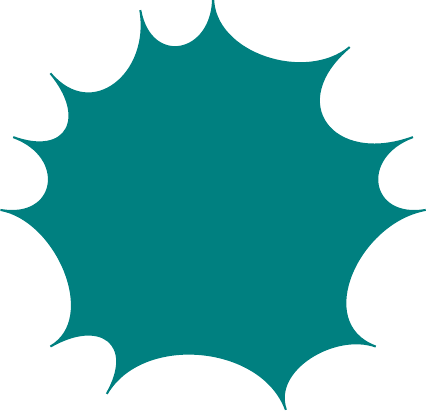
Figure 6.8: Spacetime trajectory of Gross-Mende scattering with 12 strings in d =